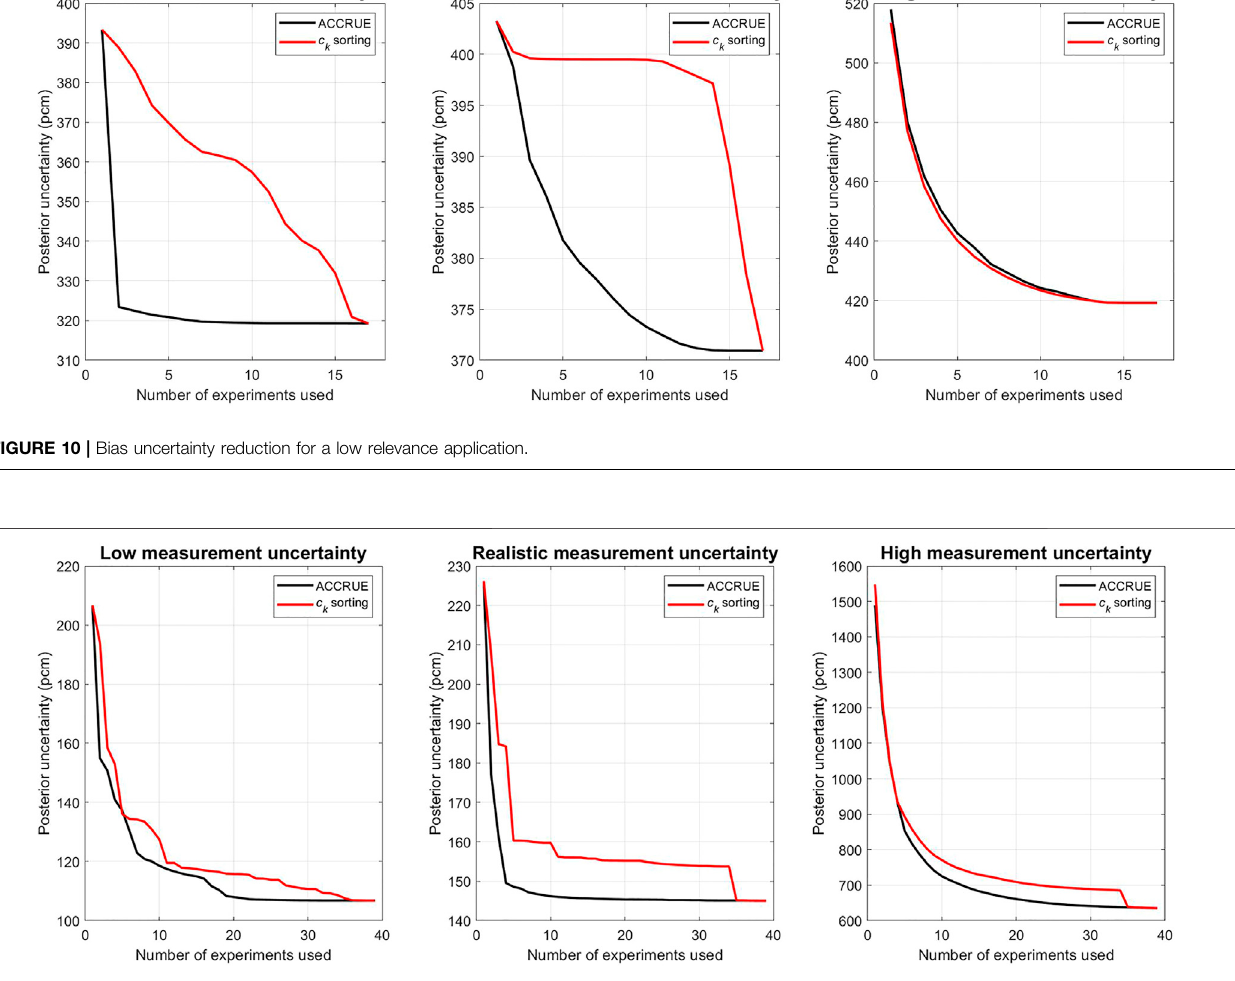
FIGURE 11 | Bias uncertainty reduction for a high relevance